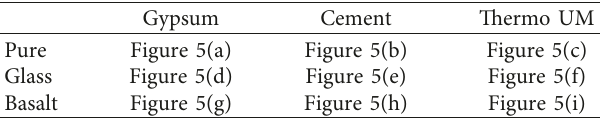
Table 4: The created combinations of matrix (plaster), dispersion (fibres), and number of their picture below. Gypsum Cement Thermo UM